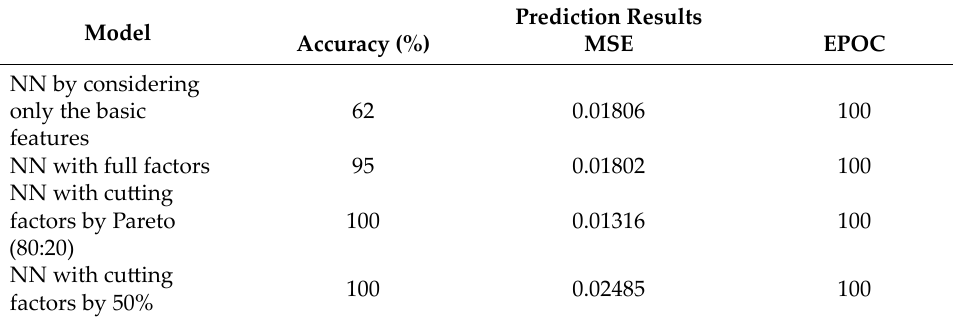
Table 2. Summarized models predicting the structure.